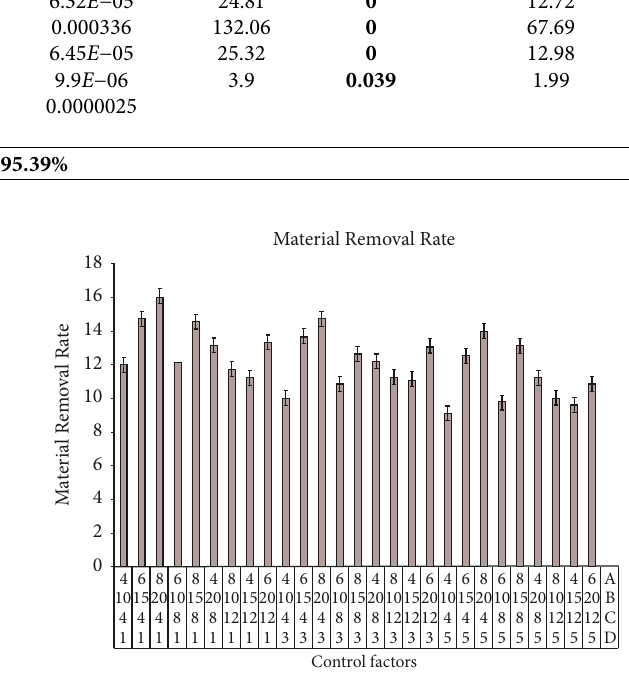
Figure 8: Influence of machining parameters on MRR.